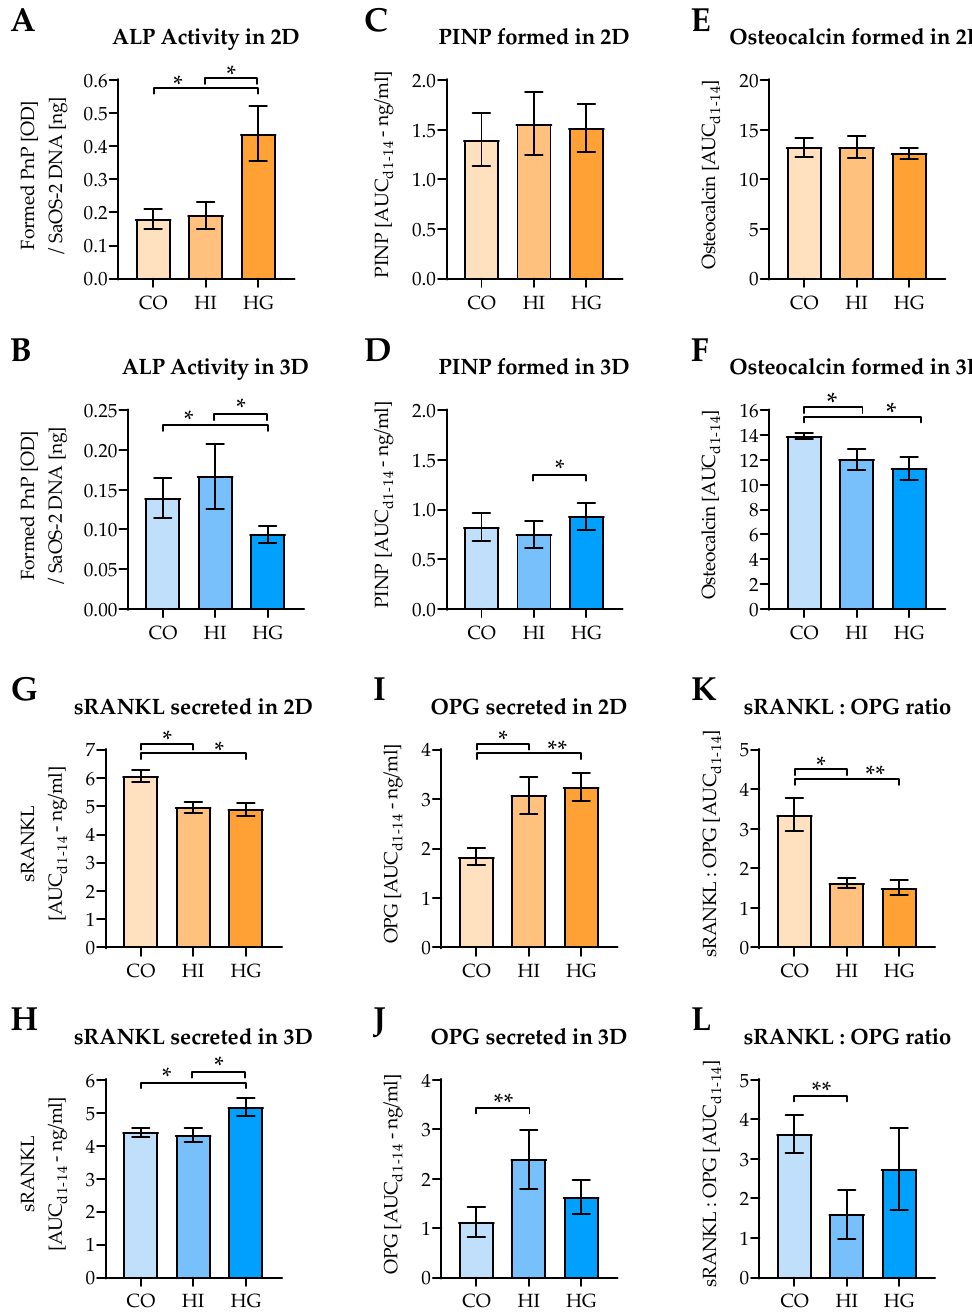
Figure 5. Influence of pre-/diabetic conditions on SaOS-2 cells’ function in 2D and 3D cocultures. THP-1 cells and SaOS-2 cells (2:1 ratio) were differentiated for 14 days as ( A , C , E , G , I , K ) 2D and ( B , D , F , H , J , L ) 3D cocultures in the presence or absence of high insulin levels (HI = prediabetic conditions) or high glucose levels (HG = diabetic conditions). On days 1, 4, 7, 10, and 14 of culture, ( A , B ) alkaline phosphatase (ALP) activity was measured. At the same time points ( C , D ) procollagen type I N-terminal propeptide (PINP), ( E , F ) osteocalcin, ( G , H ) soluble receptor activator of nuclear factor kappa-B ligand (sRANKL), ( I , J ) osteoprotegerin (OPG) levels, and ( K , L ) the sRANKL:OPG ratio were detected in the culture supernatants. ALP activity was determined on the day of culture before it dropped significantly. For the other factors the entire differentiation period was considered, and data are presented as area under the curve (AUC/mean ± SEM). Data were compared by nonparametric Friedmann test, followed by Dunn’s multiple comparison test. * p < 0.05 and ** p < 0.01 as indicated. N = 3, n = 3.